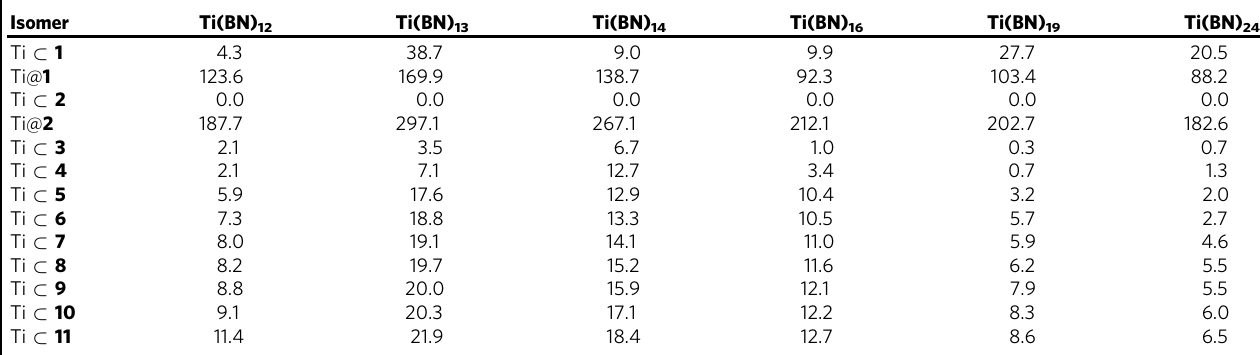
Table 2 Relative energies (in kcal mol − 1 ) of the ten lowest-energy isomers of Ti(BN) n , in comparison with isomers Ti (cid:1) 1,